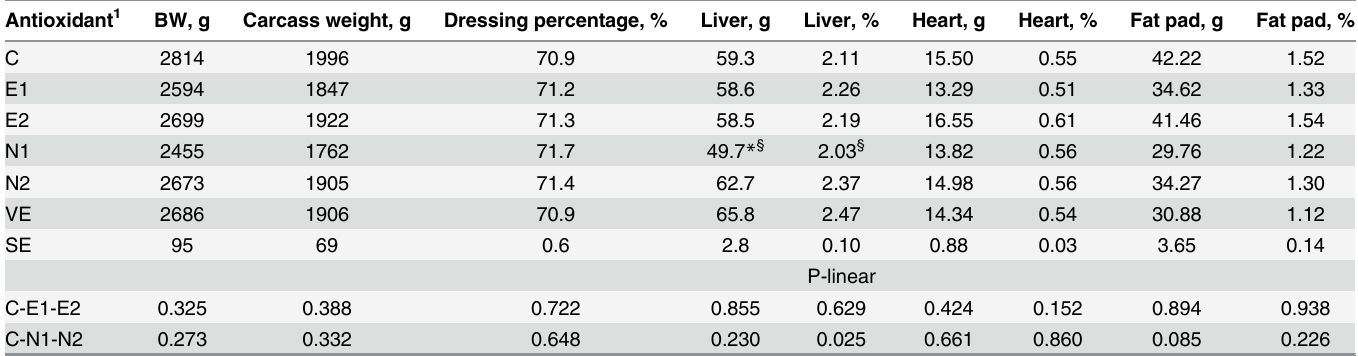
Table 2. Effect of dietary supplementation with naringin or hesperidin on broiler body, carcass and internal organ weights at the 42nd d of age (n = 10). Antioxidant 1 BW,